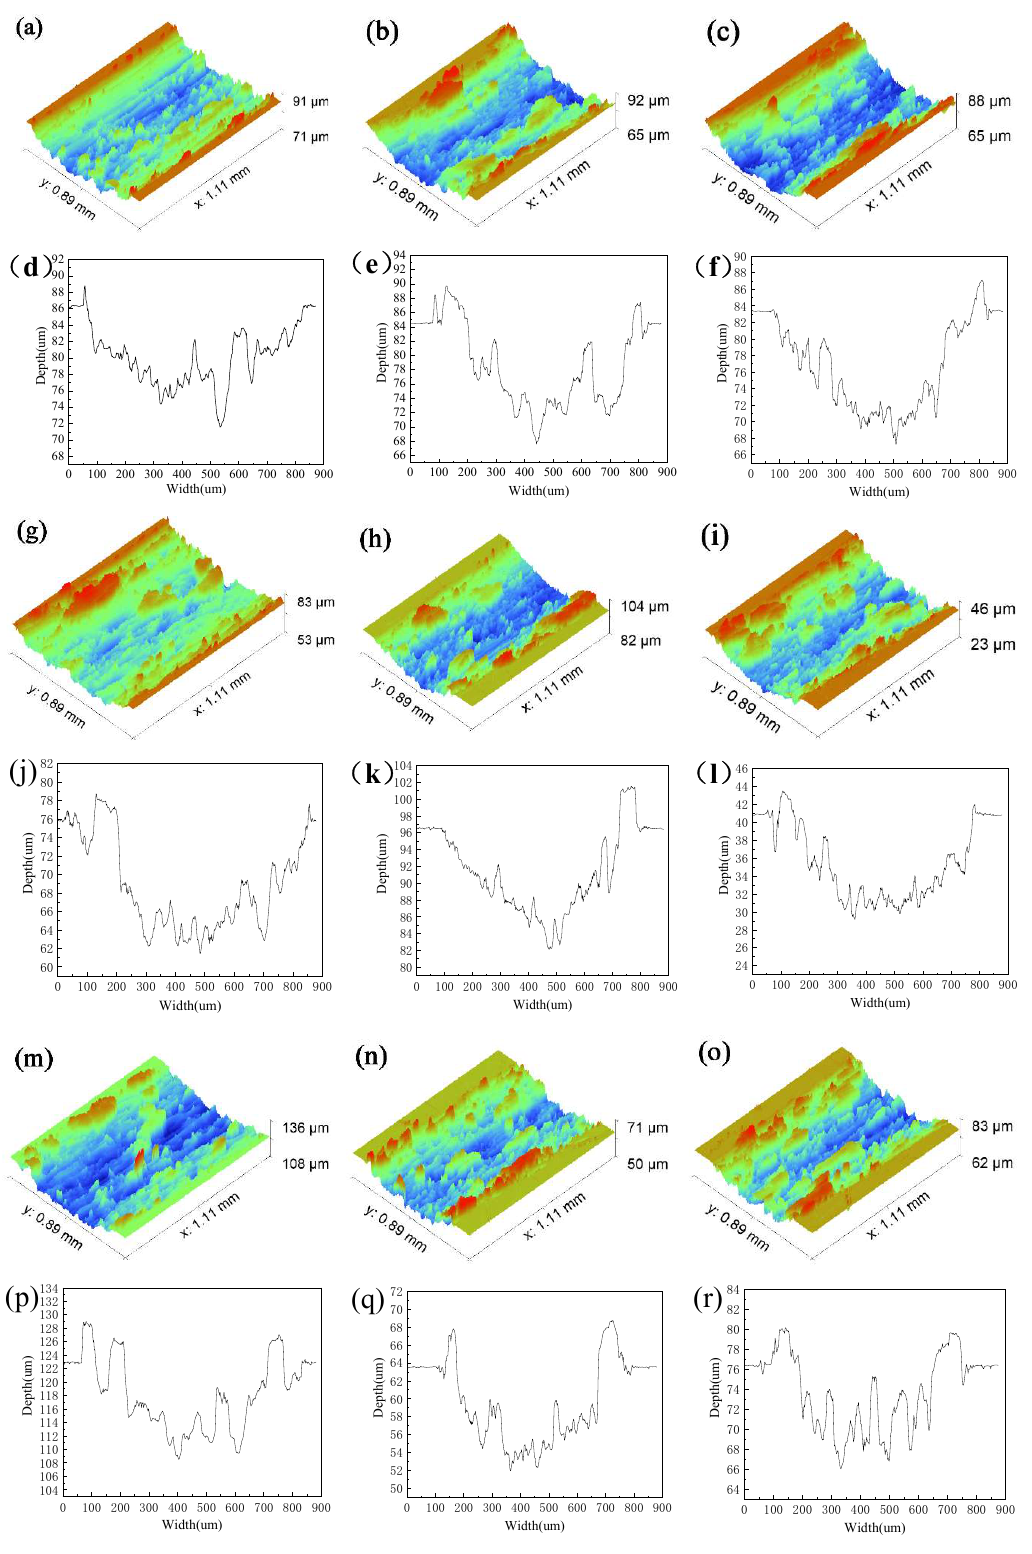
Figure 8. Morphology and depth of wear marks of different samples: ( a , d ) untexture rotation radius 15 mm; ( g , j ) untextured rotation radius 18 mm; ( m , p ) untextured rotation radius 22.5 mm; ( b , e ) electric-spark texture rotation radius 15 mm; ( h , k ) electric-spark texture rotation radius 18 mm; ( n , q ) electric-spark texture rotation radius 22.5 mm; ( c , f ) femtosecond texture rotation radius 15 mm; ( i , l ) femtosecond texture rotation radius 18 mm; ( o , r ) femtosecond texture rotation radius 22.5 mm. The shape of the wear-mark depth curve is concave. The smoother the curve is, the more fully the friction pair is run in. The longer the time to enter the stable stage, combined with the compound effect of the edge hard-phase peak, will help to achieve the optimal antifriction effect. However, the concave part of the wear-mark depth curve is disordered and irregular. The hard-phase peak of the wear mark is convex. The edge hard-phase peak is connected with the hard-phase peak of the wear mark. All these phenomena indicate that the friction is intensifying. It showed that when there are both wear-mark hard-phase peaks and edge hard-phase peaks, the reverse effect of the wear-mark hard-phase peak is much greater than the positive effect of the edge hard-phase peak. 3.3. Scanning Electron Microscope Analysis of the Worn Surface As shown in Figure 9a–f, a large number of surface spalling has occurred on the un- textured surface under any rotation radius. Moreover, there is less wear debris on the surface. However, there are large glued flakes, which are mainly concentrated in the wear- scar area. This is because at the initial stage of wear, abrasive wear is the main form. The wear debris generated by abrasive wear may accumulate and glue together due to the concentrated heat generated at the moment of friction, which will form the hard-phase peak of the wear mark. As mentioned earlier, the hard-phase peak of the wear mark ex- acerbates further wear. This is also the main reason why the friction coefficient of untex- tured samples increases gradually and it is difficult to enter stable wear. Under the same test parameters, the wear of the untextured surface is basically the same, which is not affected by the rotation radius.